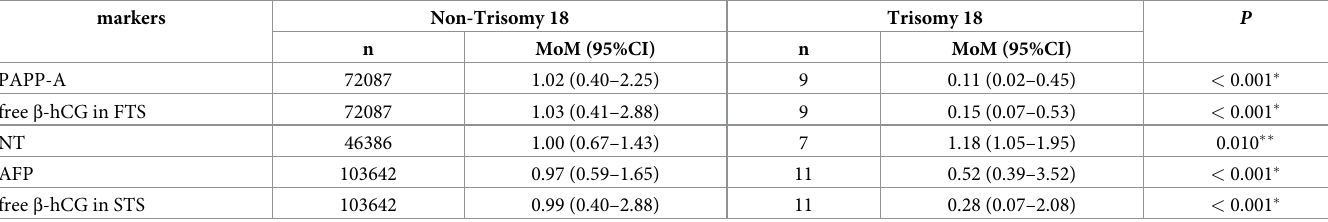
Table 6. Distribution of marker MoM values in the serum of pregnant women with or without trisomy 18 fetuses.